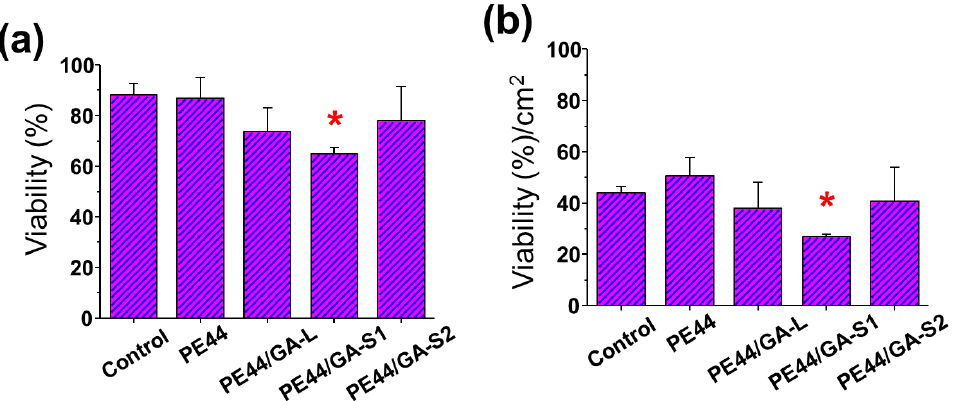
Figure 10. ( a ) viability of MDCK cells in presence of TCPS (control), unloaded PE44, PE44/GA-S1, PE44/GA-S2 and PE44/GA-L samples; ( b ) cellular adhesion onto TCPS (control) and fiber mats with unloaded or peptide-loaded fibers.